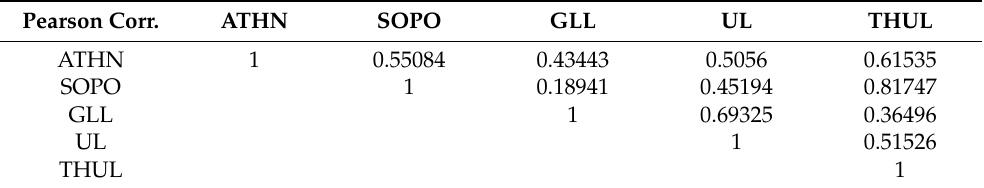
Table 2. Statistical correlation between ground stations during September 2017. Pearson Corr. ATHN SOPO GLL UL THUL ATHN 1 0.55084 0.43443 0.5056 0.61535 SOPO 1 0.18941